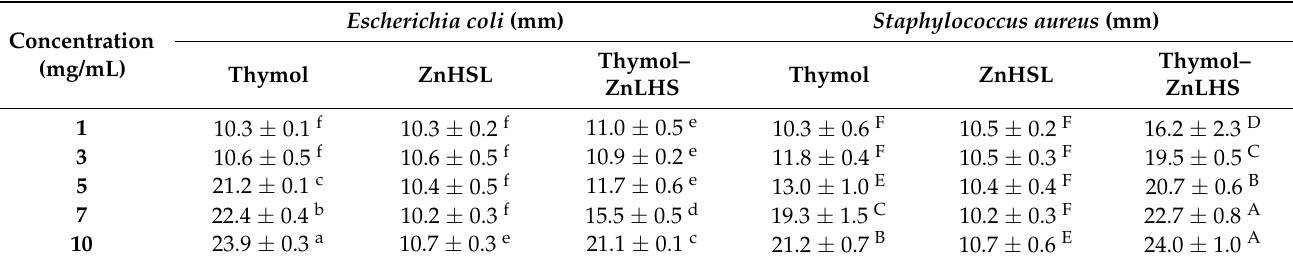
Table 2. Inhibition halo of E. coli O157:H7 and S. aureus ATCC 25,923 (SD ±